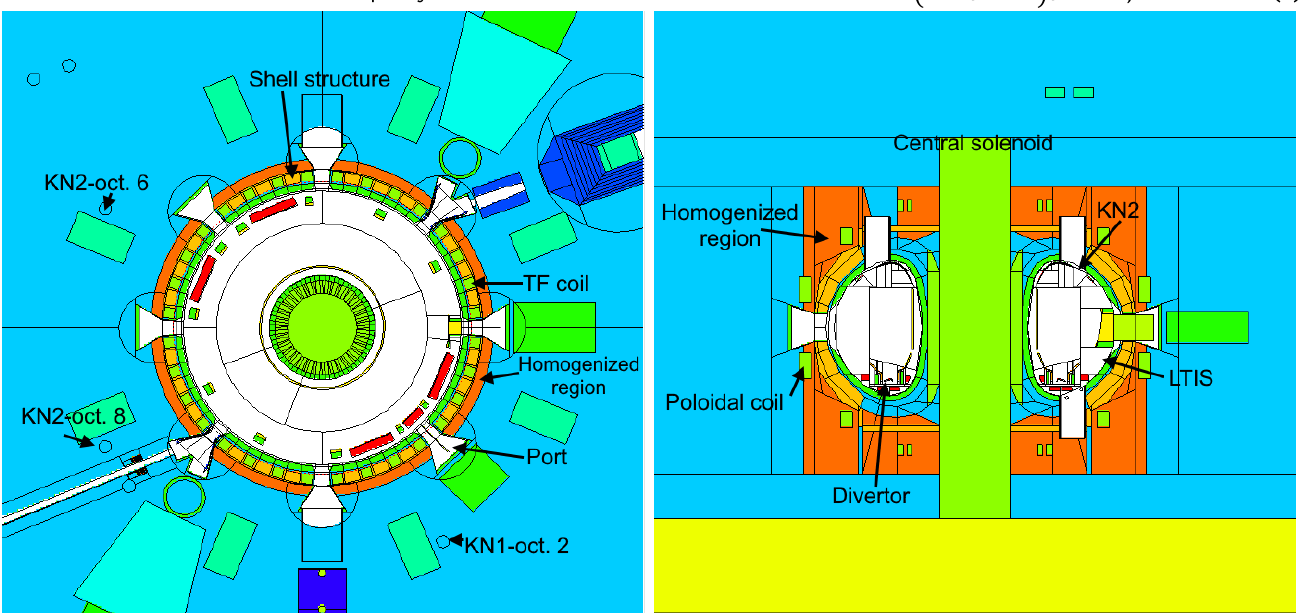
Fig. 3 Section view of the MCNP model of the tokamak JET used for computation support for the LTIS experiment. In the right figure the approximate location of the LTIS is